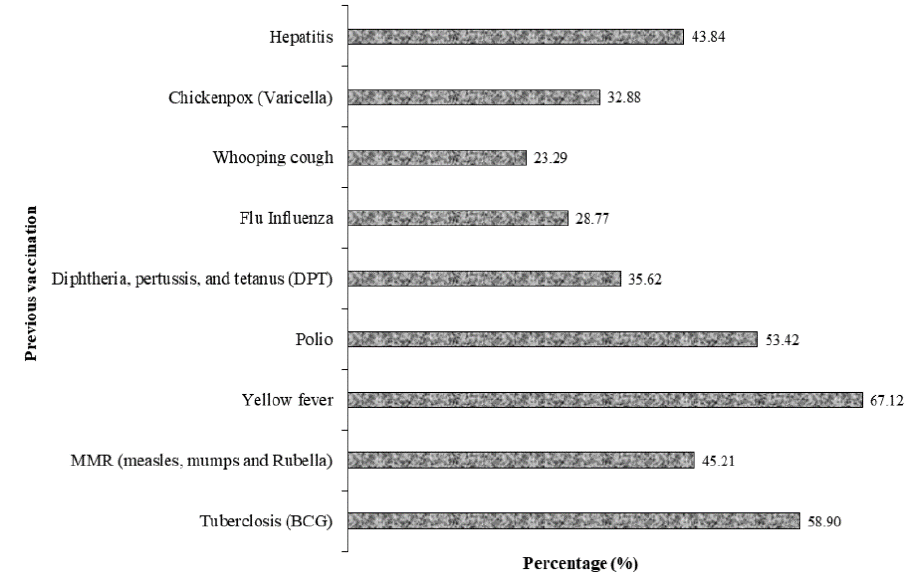
Figure 3. Percentage of previous vaccinations for other conditions among the study participants. Table 2. Other self-reported health conditions of study participants ( n =